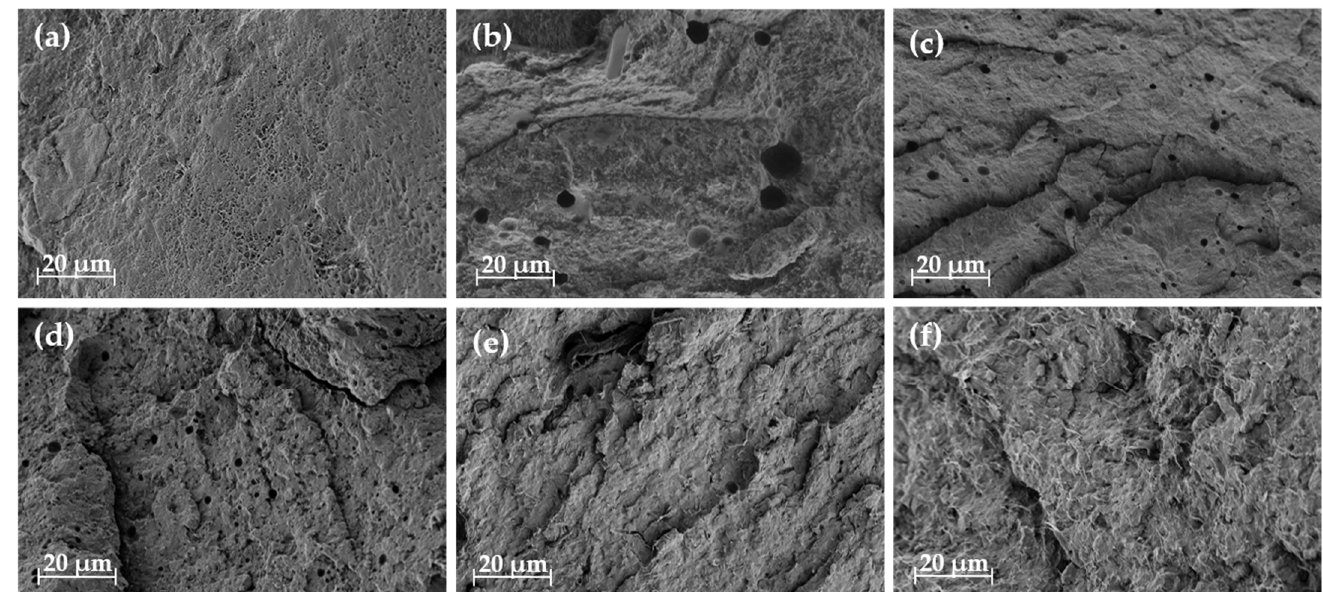
Figure 5. SEM images of cryo-fractured surfaces for different composites: ( a ) PP/2 w t% SWCNT, ( b ) PP/2 wt.% SWCNT/4 wt.% AMIM Cl, ( c ) PP/2 wt.% SWCNT/4 wt.% OMIM BF 4 , ( d ) PP/2 wt.% SWCNT/4 wt.% OMIM Cl, ( e ) PP/2 wt.% SWCNT/4 wt.% AMIM DCA and ( f ) PP/2 wt.% SWCNT/4 wt.% THTDP Cl.